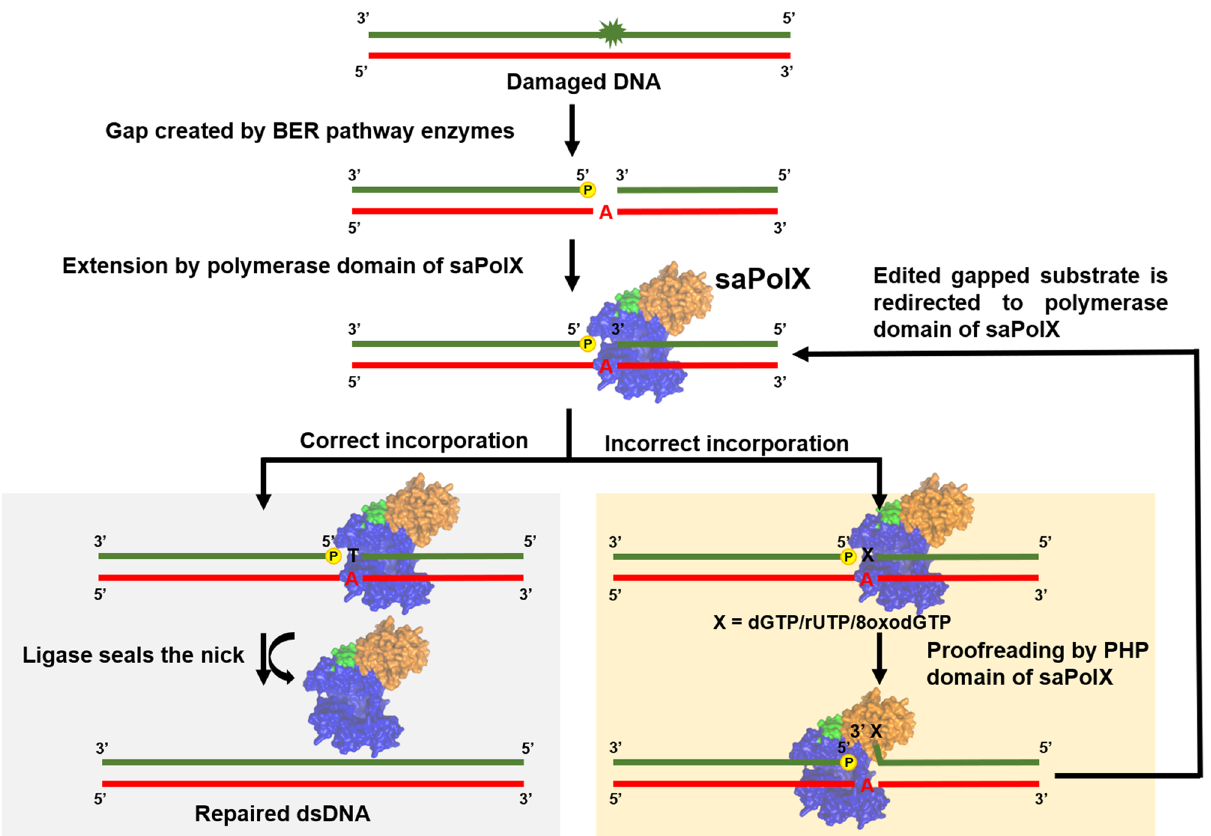
Figure 14. Model for the high-fidelity DNA synthesis by saPolX. The core polymerase domain, PHP domain and linker connecting these two domains are displayed in blue, orange and green colors, respectively. The schematic shows the interplay between the 5 ′ –3 ′ polymerization and 3 ′ –5 ′ exonuclease activities residing in polymerase and PHP domains, respectively. saPolXc incorporates either correctly paired nucleotide or mismatched nucleotide on gapped DNA substrate generated during BER pathway. The correctly filled DNA substrate is sealed by the ligase enzyme in the subsequent step. The DNA substrates with misincorporated deoxyribo-, ribo- and oxidized nucleotides are directed towards the PHP domain. The PHP domain removes these bases and redirects the gapped DNA substrate to the polymerase domain to repair it